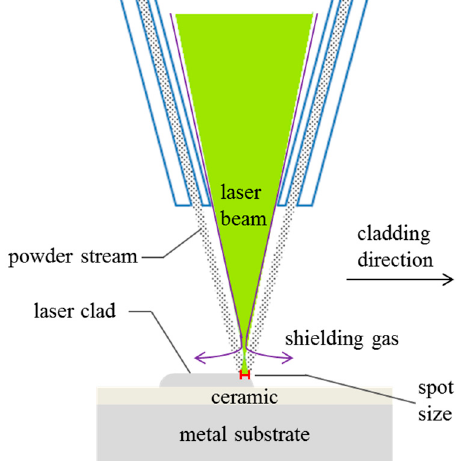
Figure 1. Schematic of laser cladding process.